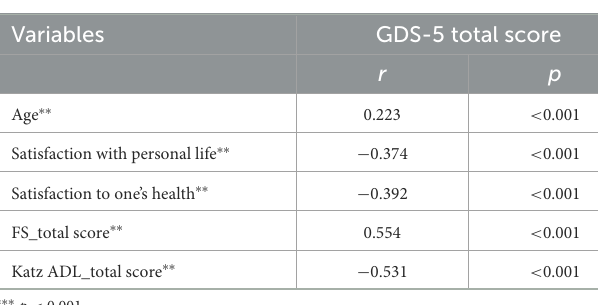
TABLE 2 Pearson’s correlations analyses for levels of depressive symptoms.